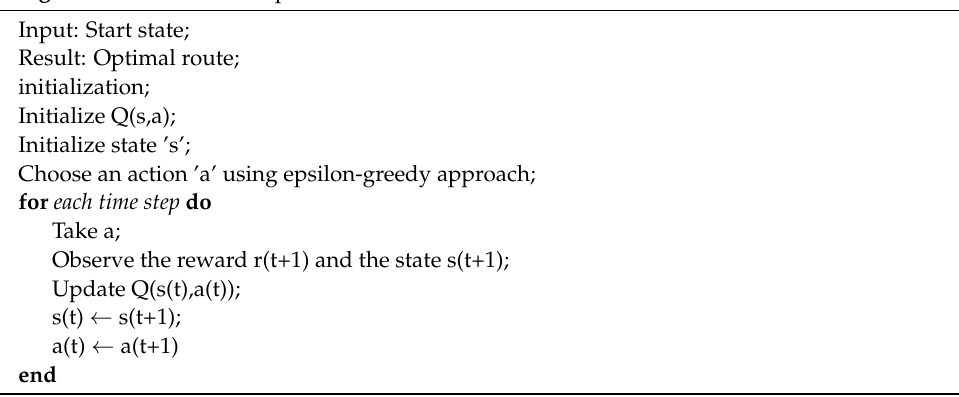
Algorithm 1: Predict the optimal route